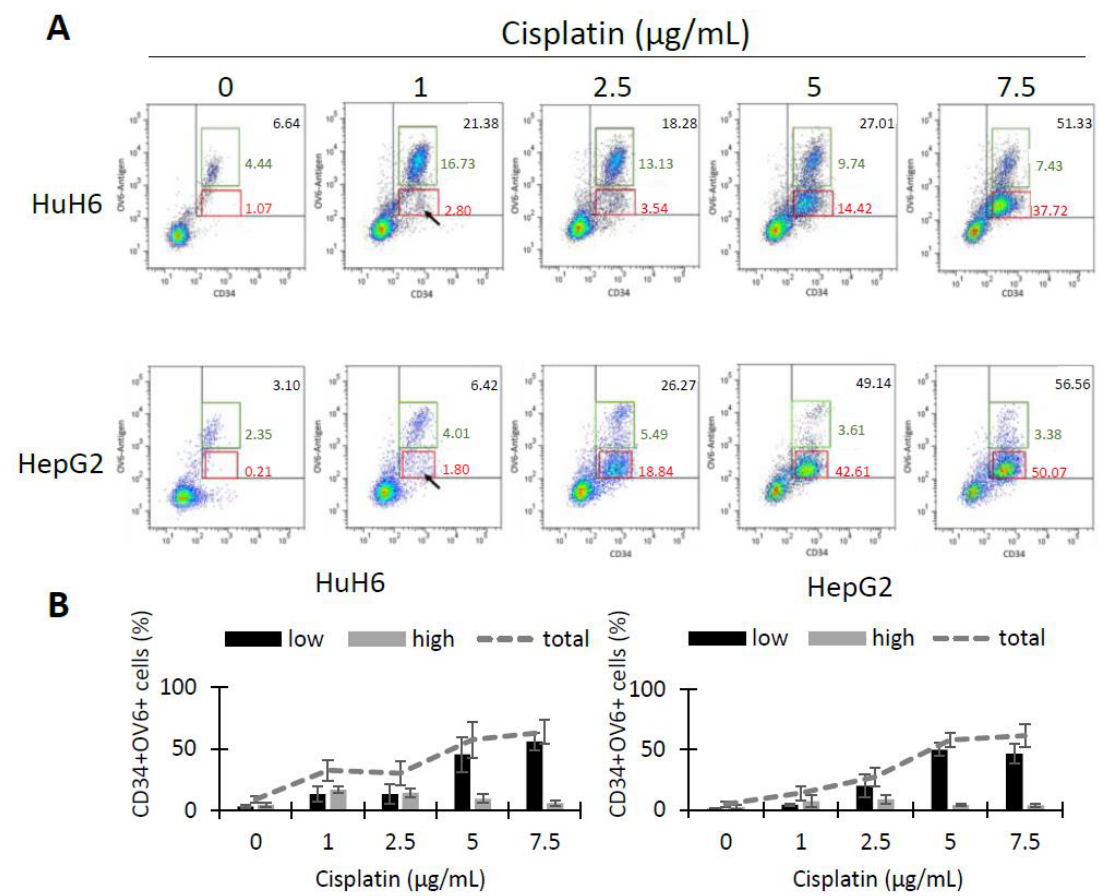
Figure 3. Cisplatin treatment reveals a second CD34 + OV-6 + subpopulation with a lower expression. ( A ) HuH6 and HepG2 cells were treated with 0, 1, 2.5, 5 and 7.5 µ g/mL cisplatin for 72 h. Surviving cells were analyzed for CD34 expression and OV-6 antibody binding by flow cytometry. The cells were gated in CD34 +/high OV-6 high (green line) and CD34 +/low OV-6 low (red line) cells. These are representative results of 7 experiments with HuH6 cells and 8 experiments with HepG2 cells. ( B ) The histograms depict the ratio of CD34 +/low OV-6 low (low, black bars) and CD34 +/high OV-6 high (high, grey bars) in each cisplatin concentration along with the total CD34 + OV-6 + population (grey line). The columns represent the means with error bars depicting the standard deviation from the